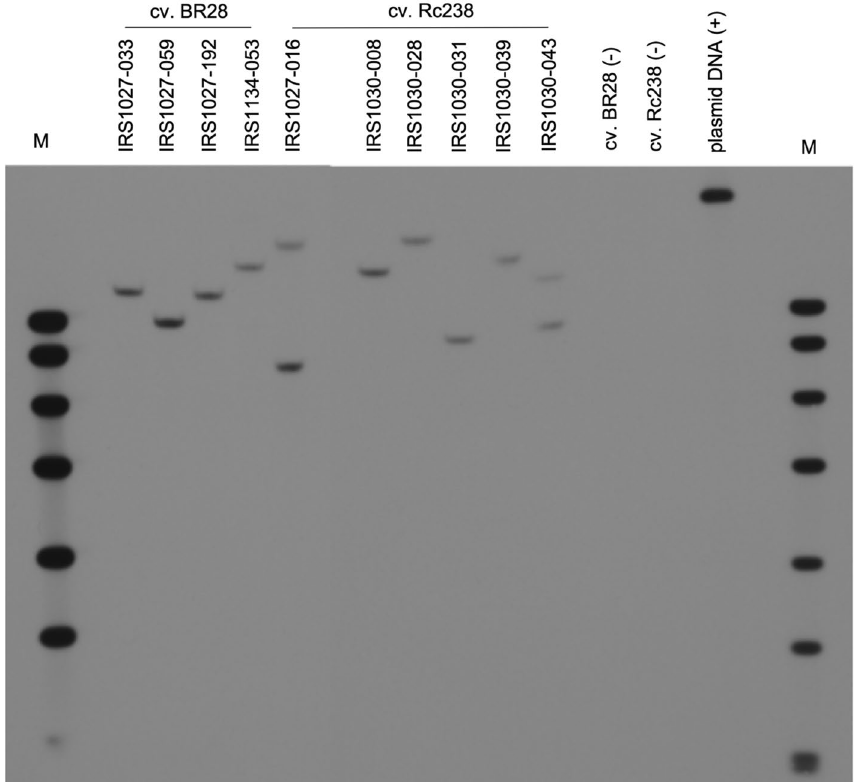
Figure 5. DNA blot analysis for the identification of T-DNA insertion sites in transgenic plants, using a ferritin probe. Genomic DNA from transgenic events in both cv. BR28 and cv. Rc238 backgrounds were extracted and digested with EcoR I enzyme prior detection with the probe. All the events have 1 copy of the T-DNA, except those events IRS1027-016 and IRS1030-043 that have 2 copies. Digested genomic DNA from non-transformed cv. BR28 and cv. Rc238 were used as negative controls. Linearized plasmid DNA of the binary vector used for the transformation was used as positive control. M: DNA Molecular Weight Marker VII, DIG labeled